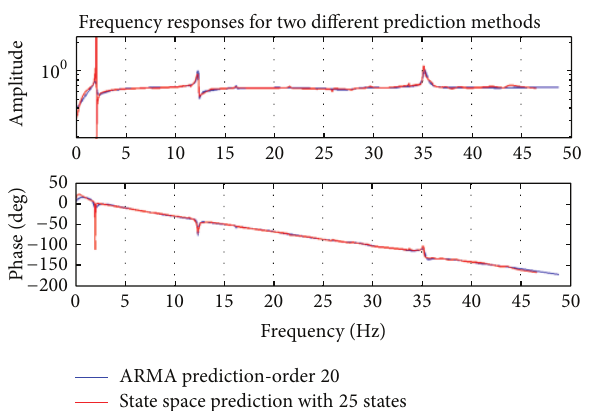
Figure 4: Frequency responses of estimated parametric models.